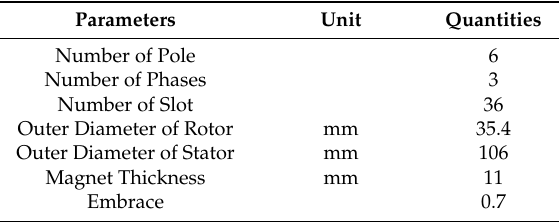
Table 4. Major Parameters of the Rotary Generator.